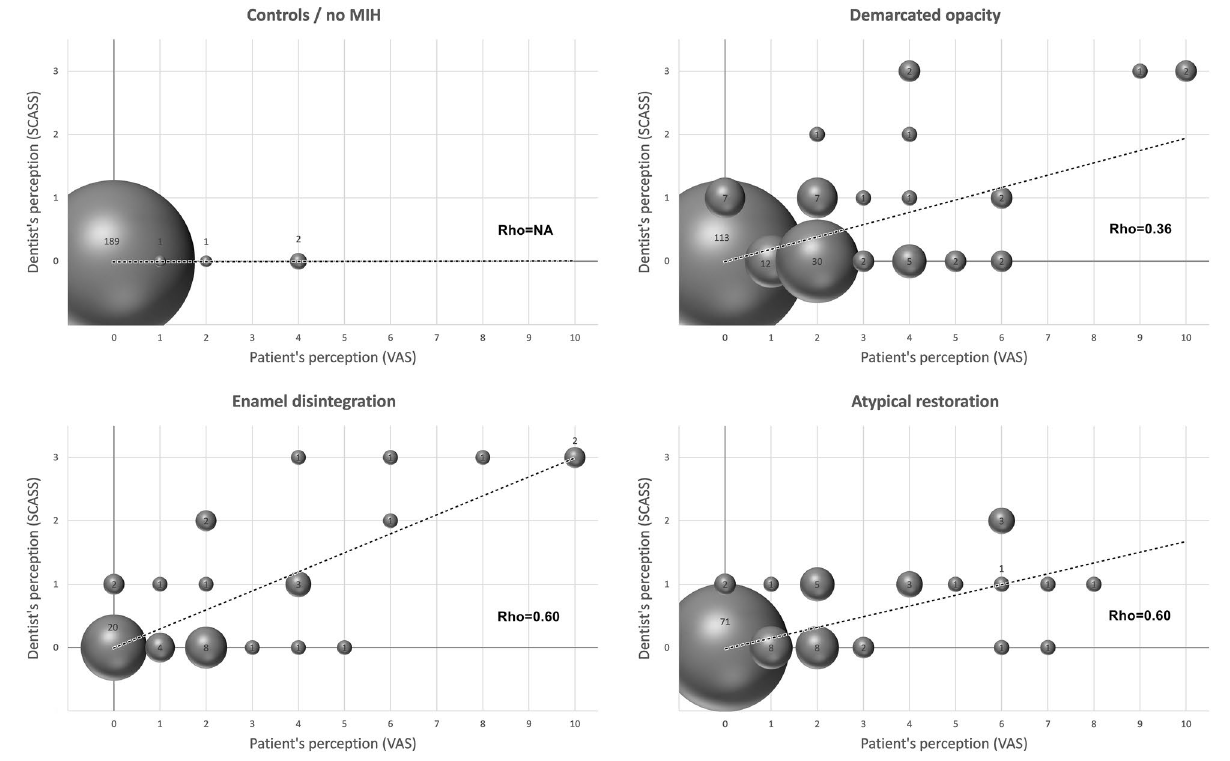
Figure 1. Spearman’s rank correlation between the perceptions of the dentist (SCASS) and the patient